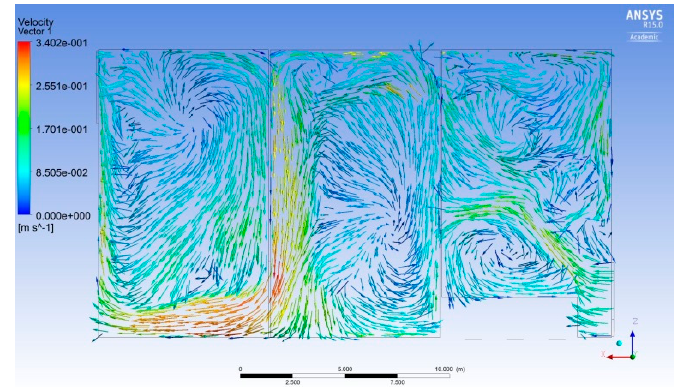
Figure 14. Velocity vector plot 1-meter depth (reduced duration).